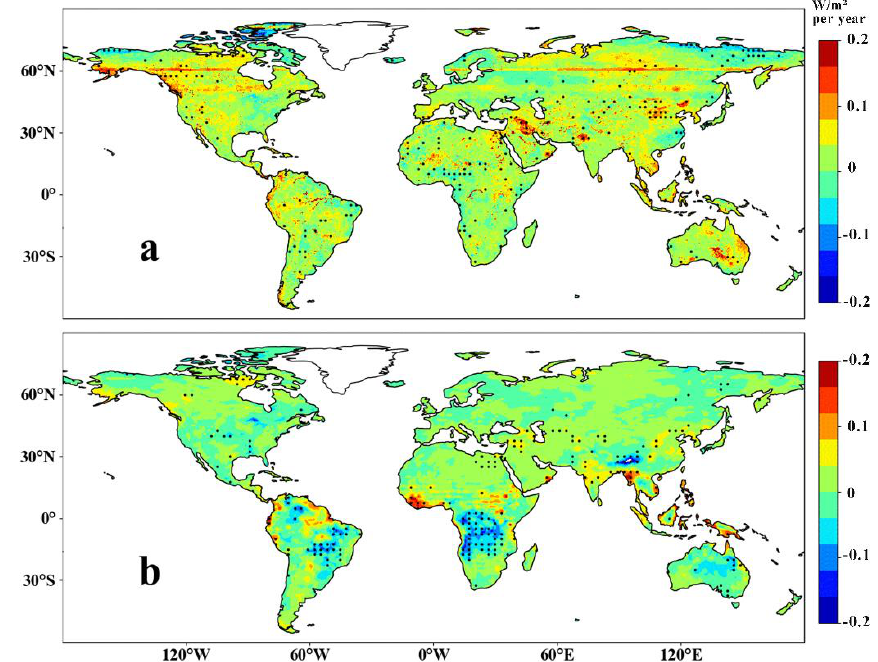
Figure 4. Trends of GLASS Rn ( a ) and MERRA-2 Rn ( b ) during the period of 2007–2017. The black points refer to pixels with 95% confidence.